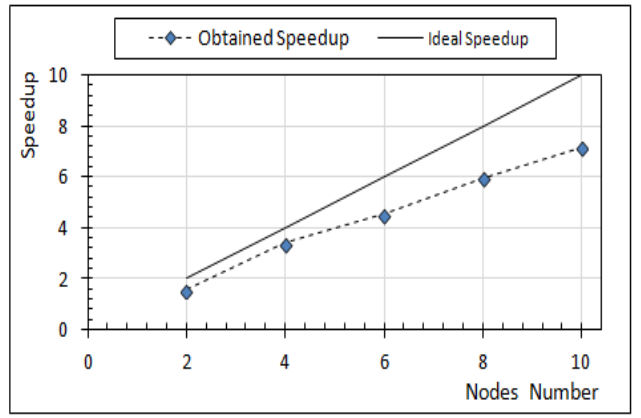
Figure 12. Speedup considering the parallel execution of the GA concerning the nodes number used to evaluate the individuals and based in a fixed number of eight processes of execution of the FEM program.